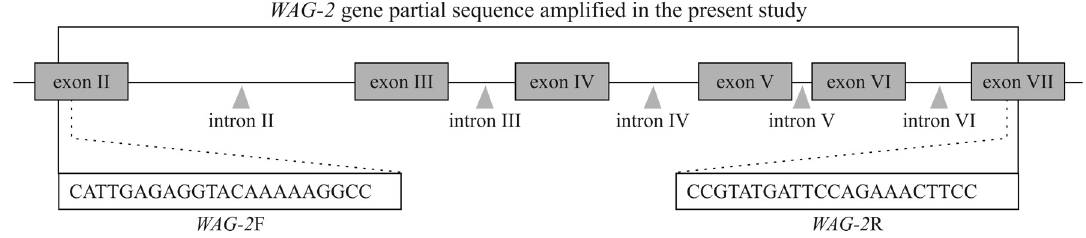
Figure 1 - Schematic drawing of the WAG-2 gene partial sequence showing the amplified region and location of primers used in this